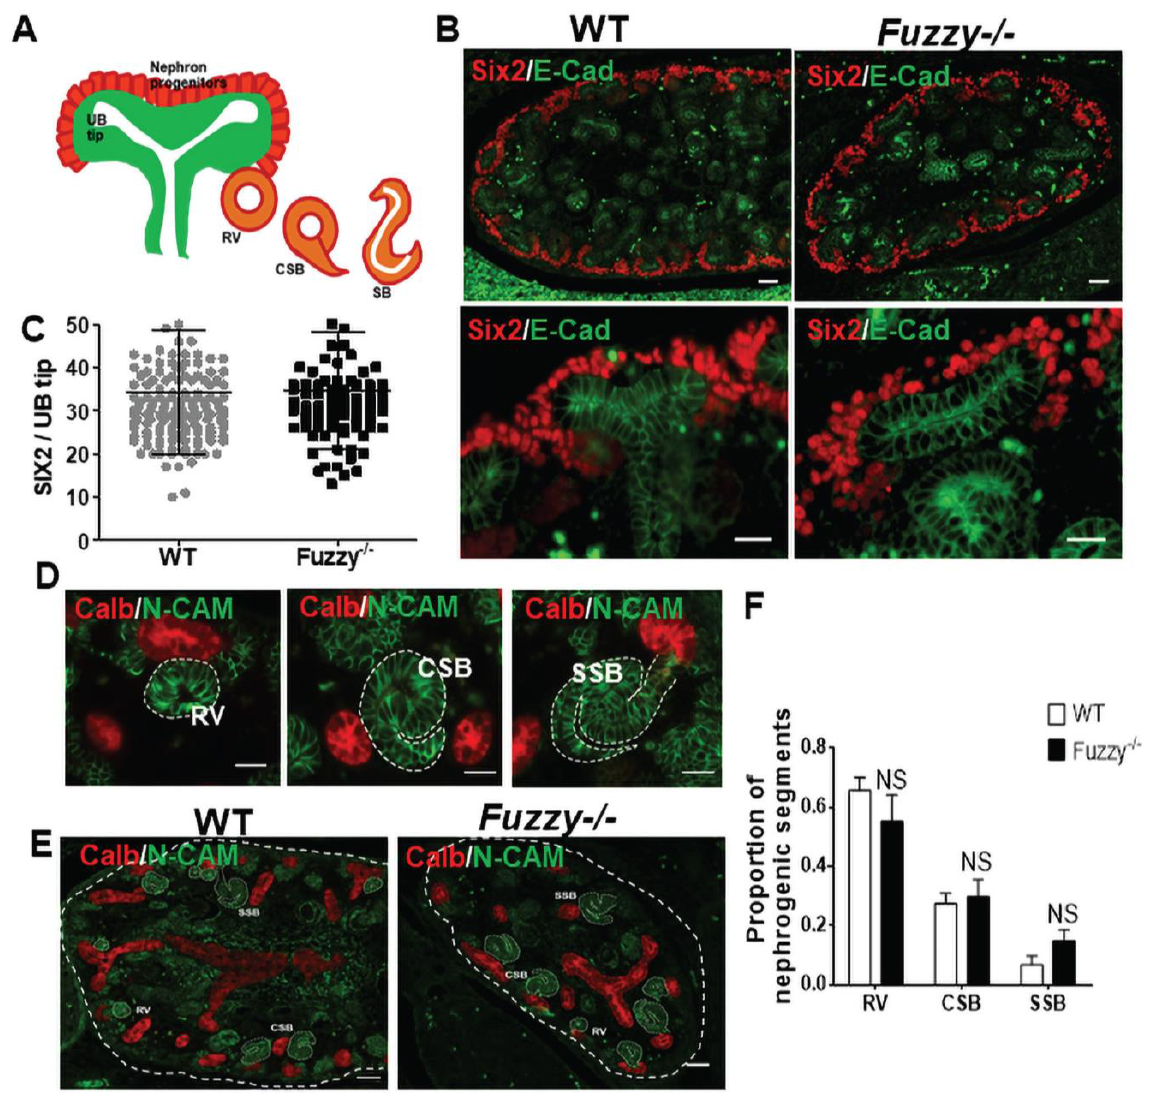
Figure 2. Early nephrogenesis in Fuzzy−/− embryonic kidneys. ( A ) Schemata of early nephrogenesis: nephron progenitor cells (red), UB tip (green), renal vesicle (RV), comma-shaped body (CSB), S-shaped body (SSB)–all depicted in orange. ( B ) Sections of wildtype and Fuzzy − / − embryos immunostained with anti-Six2 (red) and anti-E-Cadherin (green) antibodies; scale bars = 50 µM top panels and 25 µM bottom panels. ( C ) Statistical analysis of Six2+ cells per UB tip: WT ( n = 166 UB tips) and Fuzzy −/− ( n = 74 UB tips) from 4 embryos per genotype. ( D ) Morphological representation of RV, CSB and SSB identified by staining with anti-N-CAM antibody (green). Staining with anti-calbindin antibody (red) was used to visualize ureteric buds; scale bars = 25 µM. ( E ) Wildtype and Fuzzy −/− kidney sections immunostained as in D; scale bars = 50 µM. ( F ) Statistical analysis of early nephrogenesis: WT (total n = 101 developmental structures: RVs, CSBs & SSBs), Fuzzy −/− (total n = 103 developmental structures) from 4 embryos per genotype, 2 kidneys per embryo were analyzed. NS = not significant.